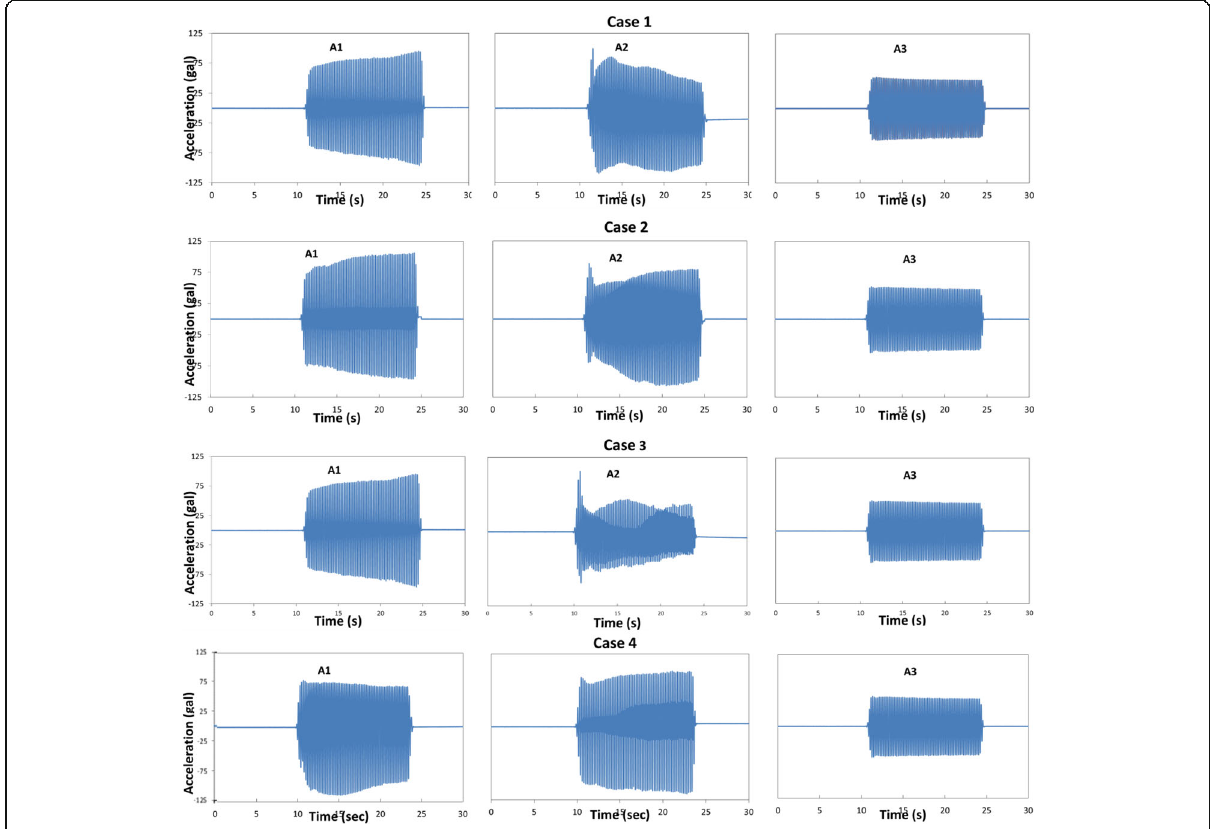
Fig. 8 Acceleration time